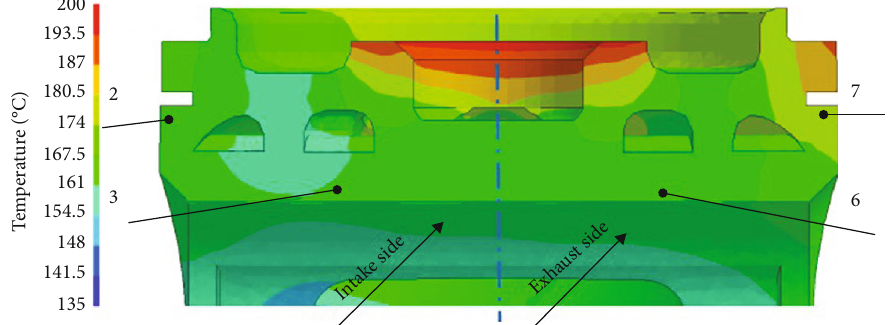
Figure 7: The temperature distribution of the piston head.